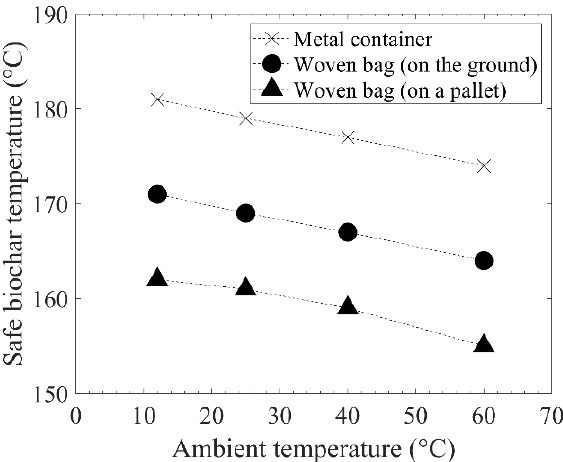
Figure 11. The safe biochar temperatures for safe storage in different types of containers. (storage condition: ρ c ,0 = 200 kg m − 3 , H container = 1 m, t = 8